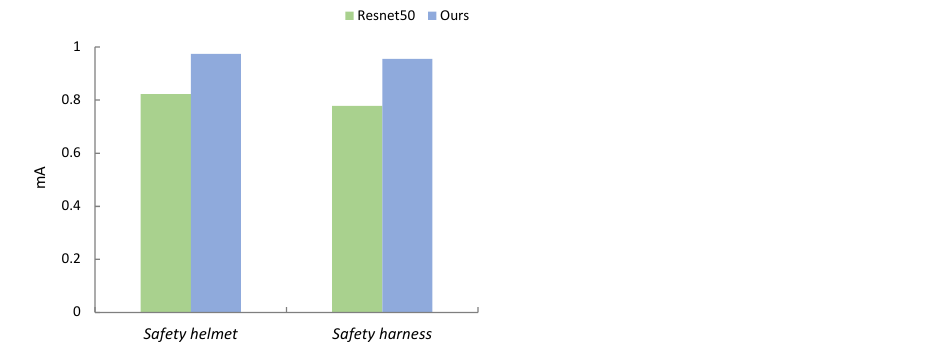
Figure 15. The mA comparison of different models. Resnet50 stands for backbone. Ours stands for adding a transformer after Resnet50 to learn relational knowledge.